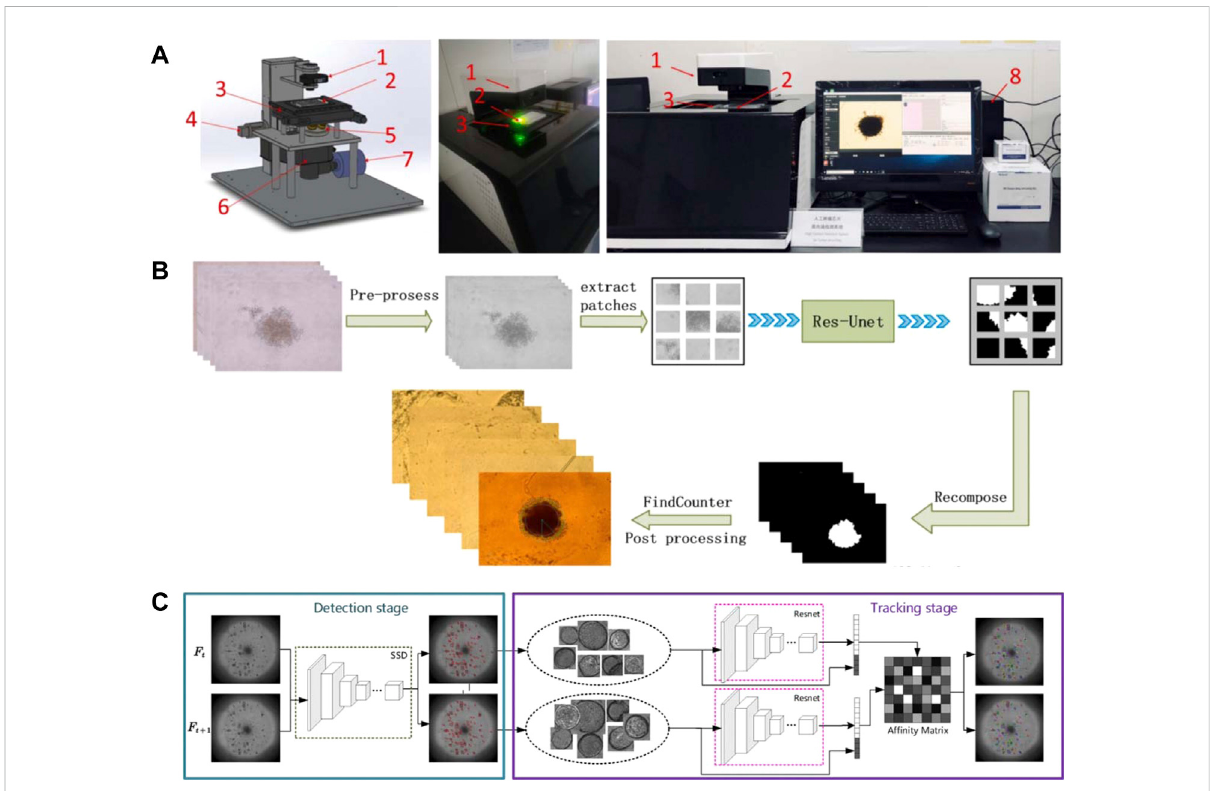
FIGURE 11 Relevantresultsofarti fi cialintelligencecombinedwithorganoids. (A – B) Systemandprocessforedgedetectionoftumorspheres(adaptedand modi fi ed from Chen et al., 2021b). (A) The SMART system for automated imaging and analysis. 1) Condenser with light source; 2) sample plate; 3) motorized x,y stage; 4) motorized Z-axis module; 5) objective wheel; 6) fi lter wheel; 7) CCD; 8) computer to control SMART system with developed software interface. (B) The process of tumor sphere edge detection. (C) Pipeline for organoids tracking (adapted and modi fi ed from Bian et al.,